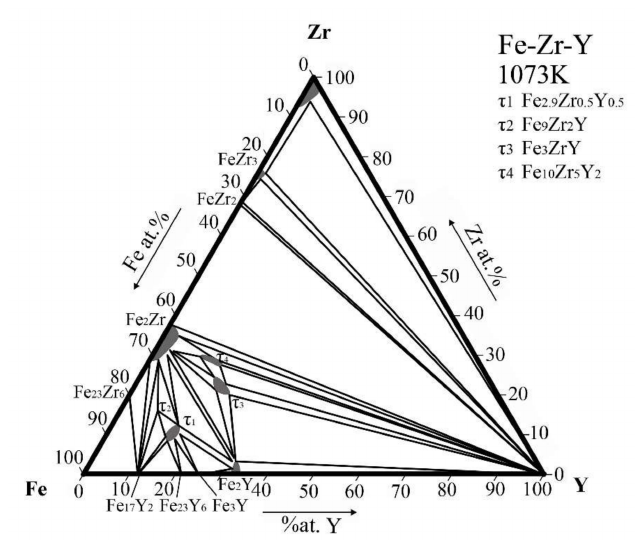
Figure 6. Isothermal section of the Fe-Zr-Y ternary system at 1073 K obtained in this